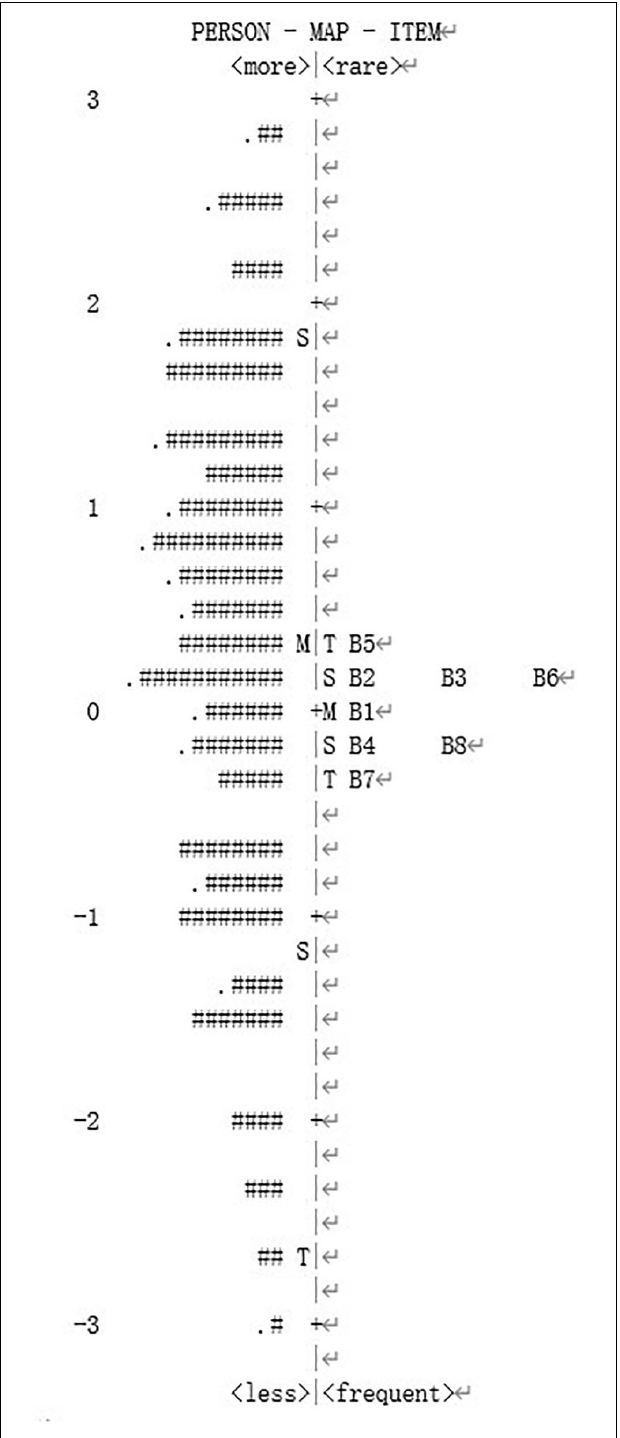
FIGURE 1 | Person-item map for the